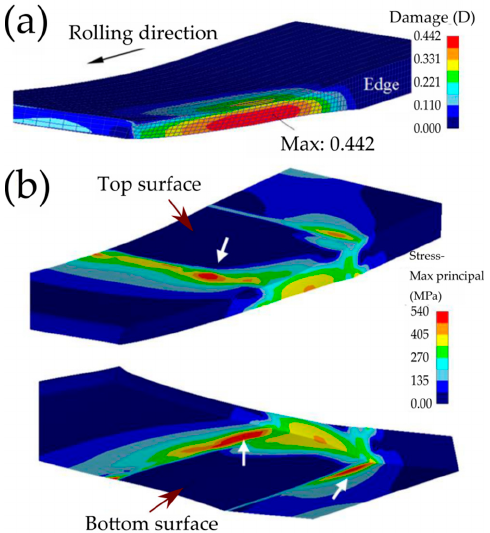
Figure 13. ( a ) Field of the material damage ( D ) and ( b ) tensile stresses developed during HRDSR (friction coefficient is 0.4; thickness reduction is 50%; rolling speed is 1.0 m/s; SR is 1.5) [38].